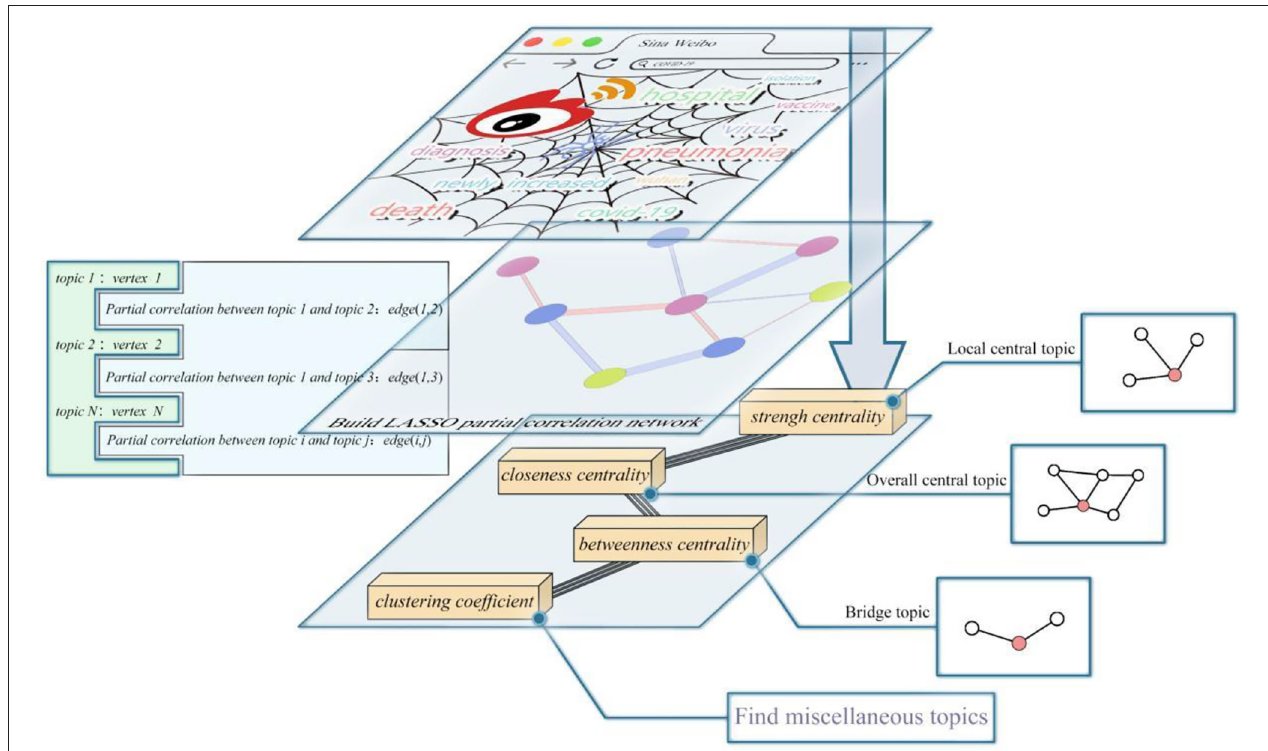
FIGURE 1 | The research